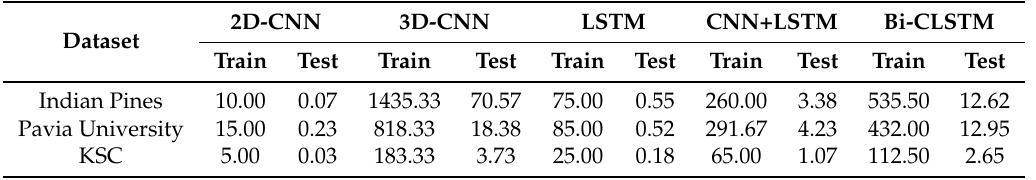
Table 12. Computation time (min.) of five deep learning methods on three